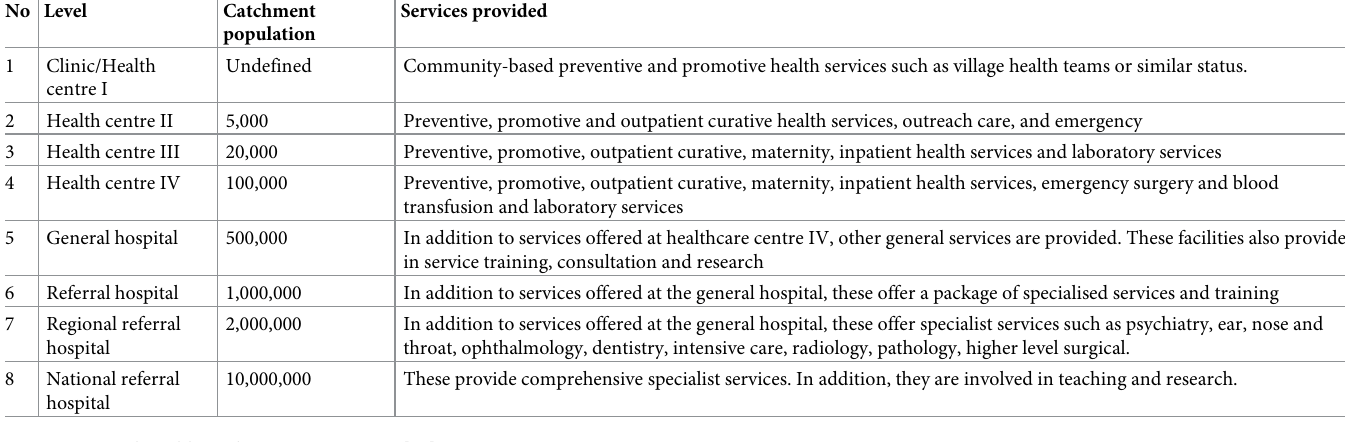
Table 1. Catchment population and services offered across the different healthcare facility levels in